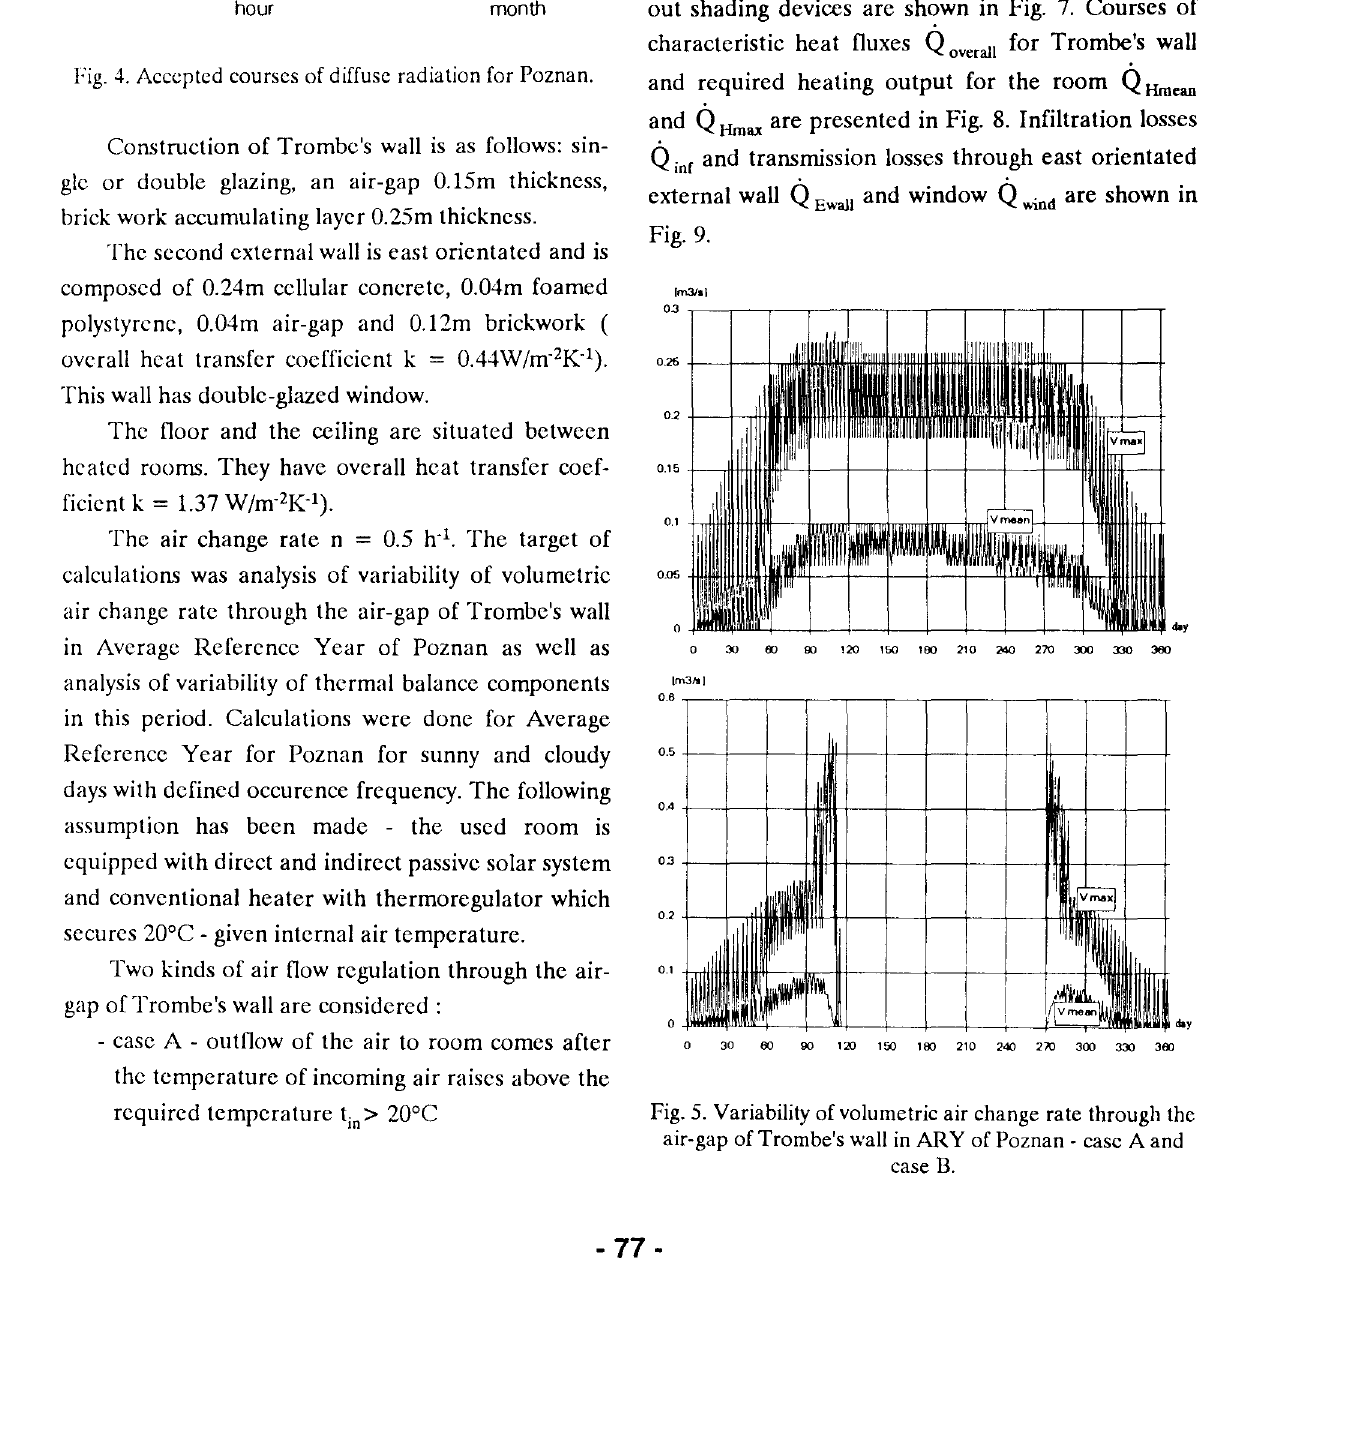
Fig. 5. Variability of volumetric air change rate through the air-gap of Trombe's wall in AR Y of Poznan - case A and case